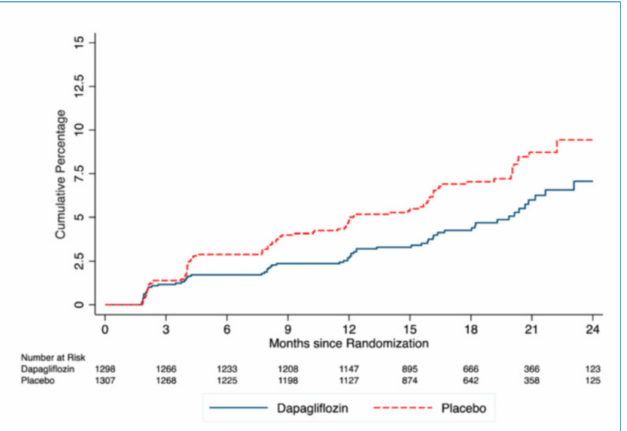
Figure 9. Incidence of new-onset type 2 diabetes mellitus (T2DM) in dapagliflozin vs. placebo groups in the Dapagliflozin and Prevention of Adverse Outcomes in Heart Failure (DAPA-HF) trial. The hazard ratio (HR) for incident T2DM in the dapagliflozin group compared with placebo was 0.68 (95% CI 0.50–0.94; P50.019), with an early divergence of the event curves. Inzucchi, S.E. et al., Diabetes Care 2021; 44:586–594 (Ref.